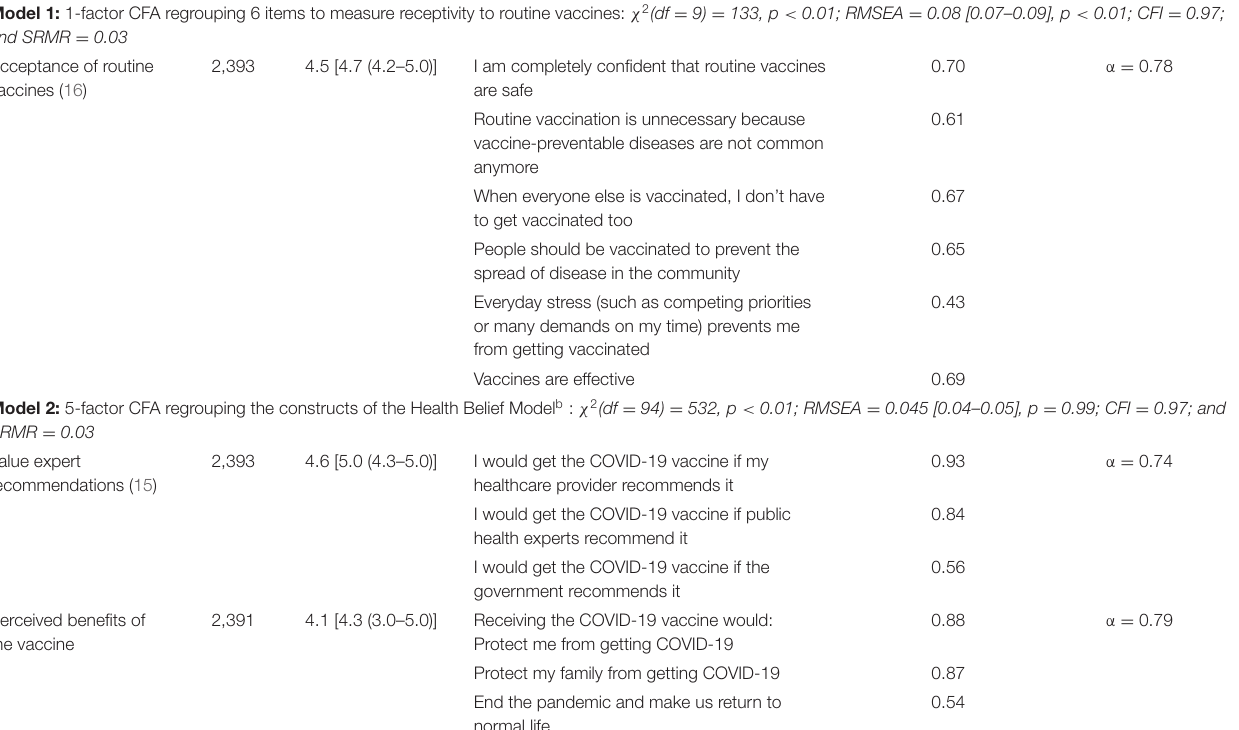
TABLE 2 | Vaccine perceptions scale scores and psychometric properties assessed by confirmatory factor analysis (CFA). Scale n Mean [Median Items Standardized factor (IQR)] a